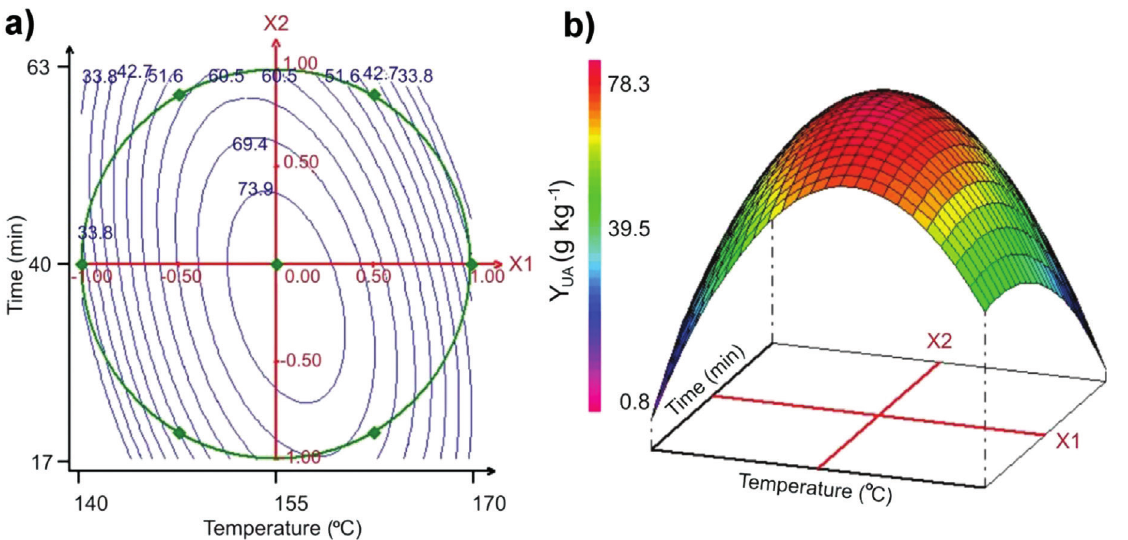
, as a function of reaction temperature and UA